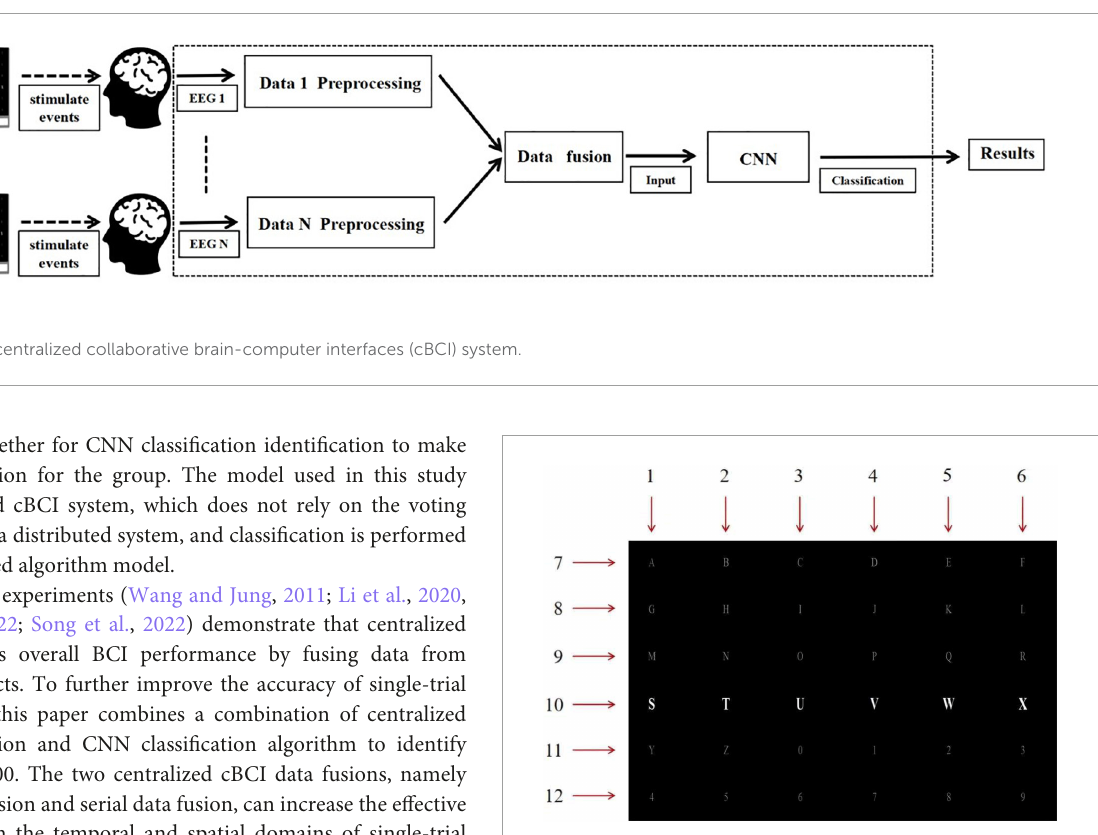
FIGURE2 P300 speller matrix and corresponding row/column labels.